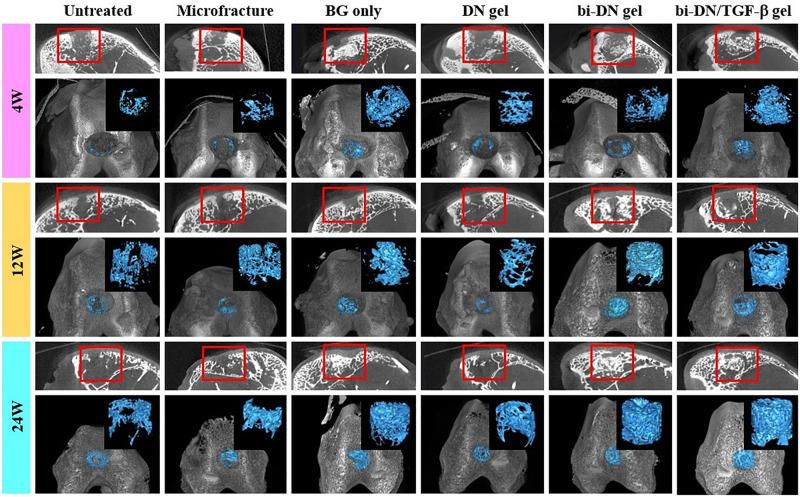
Three-dimensional reconstruction micro-CT images of sagittal plane, newly regenerated bone (blue tissues) and entire femoral condyle at 4, 12, and 24 weeks after surgery. The volume and structure of trabecula were displayed clearly. Red boxes can highlight the quality of new bone from the surface layer to the deep space (BG, bioactive glass; DN gel, GC/Alg double network hydrogel; bi-DN gel, double-layered DN gel).